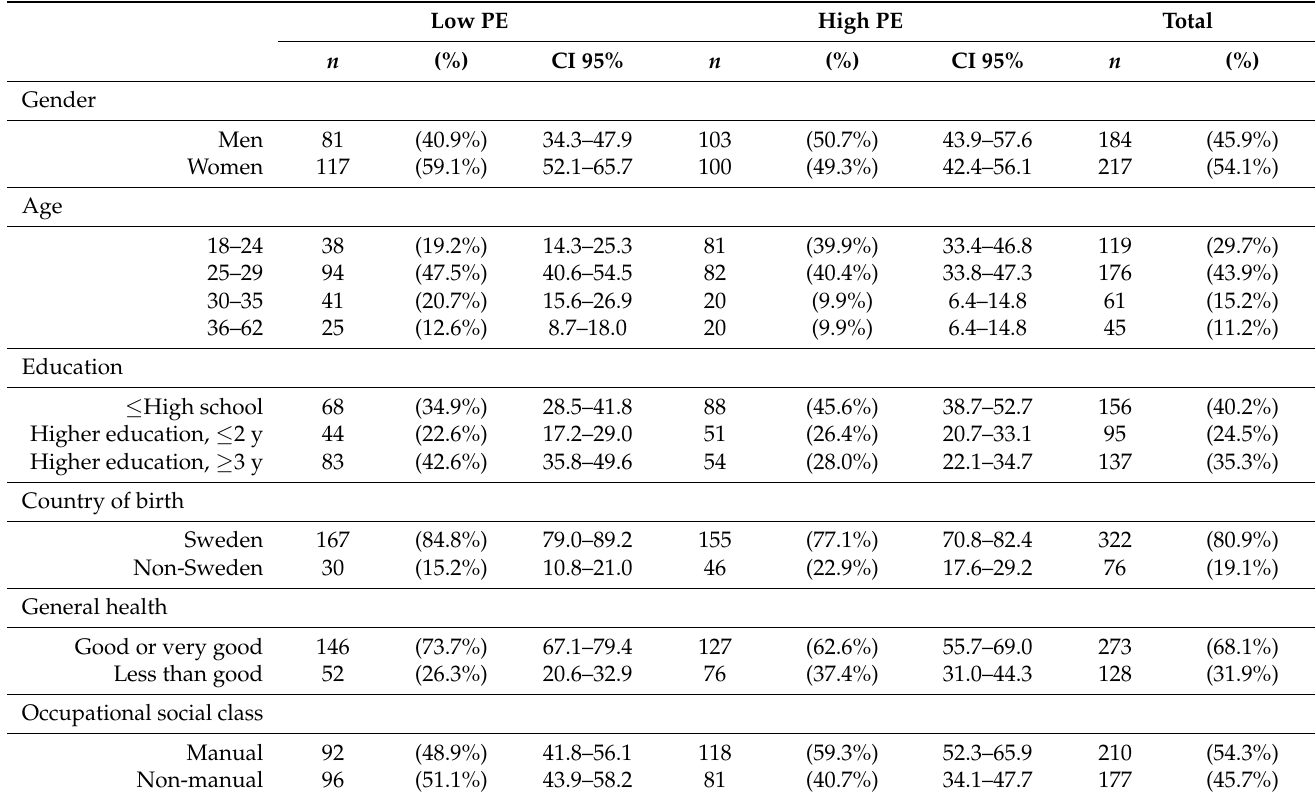
This table contains missing values: Education: 13 missing, Country of Birth: 3 missing, and Occupation: 14 missing.